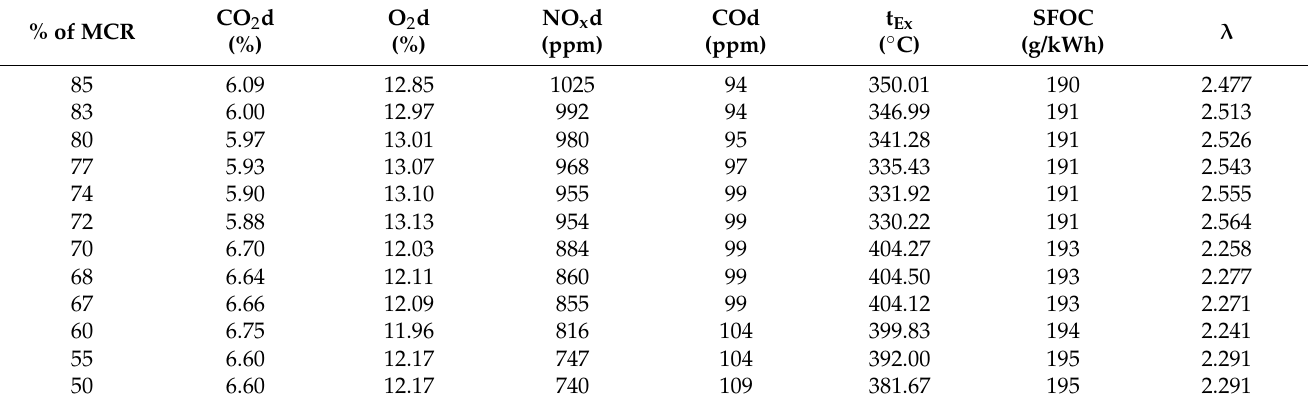
Table 3. Simulated Ro-Pax vessel engine operating and exhaust gas simulated